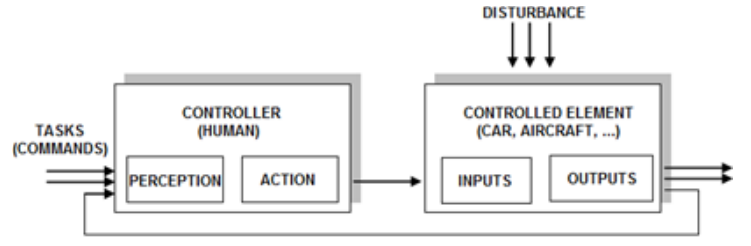
Figure 1. The human-machine interaction as a control loop